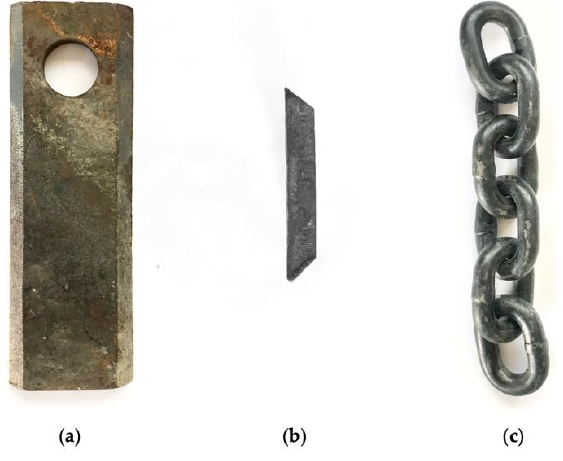
Figure 2. Different kinds of cutting tool: ( a ) blade; ( b ) cross section of the blade; ( c ) chain. Table 1. Cutting tools’ technical characteristics.